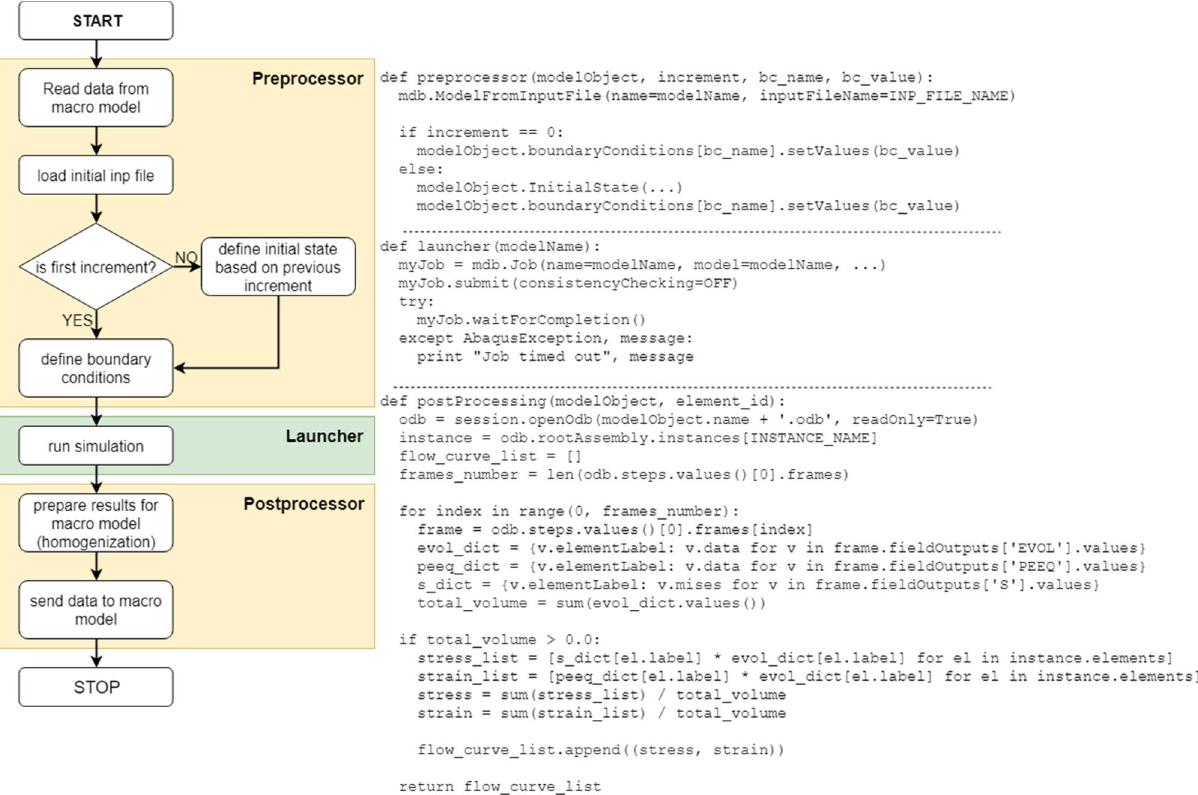
Fig. 4 Diagram of the micro model